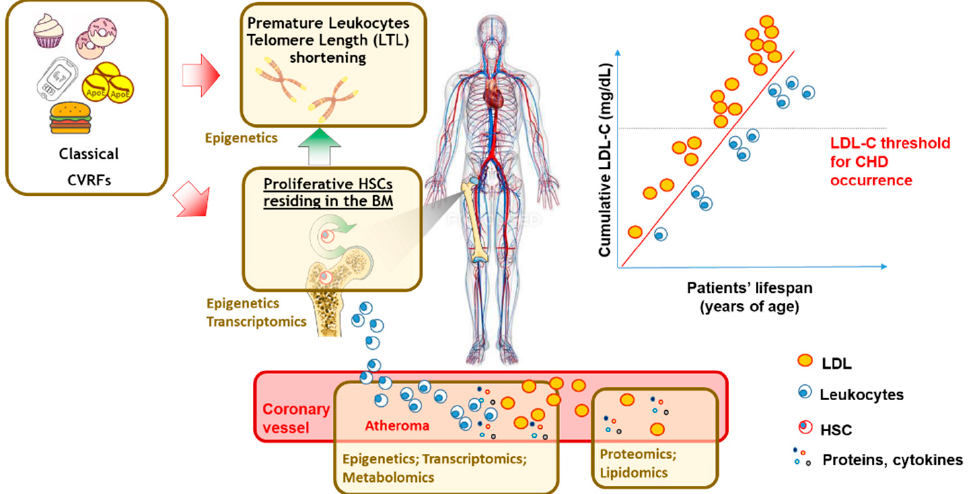
Figure 3. Applicability of “-omics” to prevent the elevated LDL-C burden and the hematopoietic expansion associated with elevated ACVD risk. Green box indicates the tissues, the cells and/or the molecular markers that can be characterized by different -omic approaches. “BM” = Bone Marrow; “CHD” = Coronary Artery Disease; “CVRFs” = Cardiovascular Risk Factors; “HSCs” = Hematopoietic Stem Cells; “LDL” = Low Density Lipoprotein.